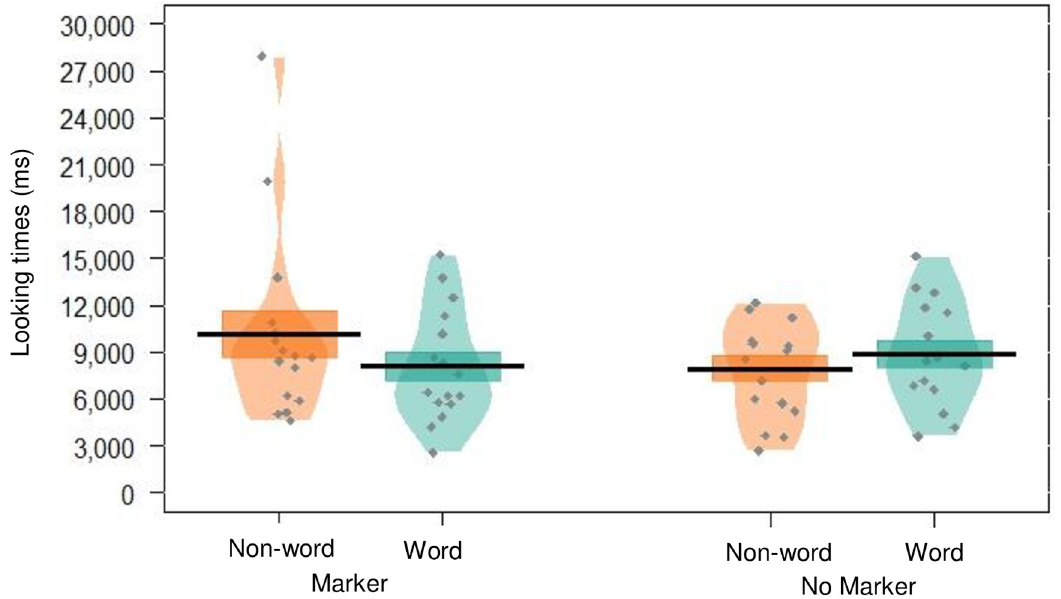
Fig 4. Pirate plot depicting the (raw) mean looking times to words and non-words, given for each condition. Black lines indicate the mean, and the coloured blocks indicate SE . The distribution of looking times is given for each group, with individual data points in grey. We note that subsequent supplementary exploratory analysis found that infants in the No Marker group were not homogeneous in their looking preferences–thus this visualisation combines data from two opposing preferences; a novelty preference (children with High CDI scores) and a familiarity preference (children with Low CDI scores); see Fig